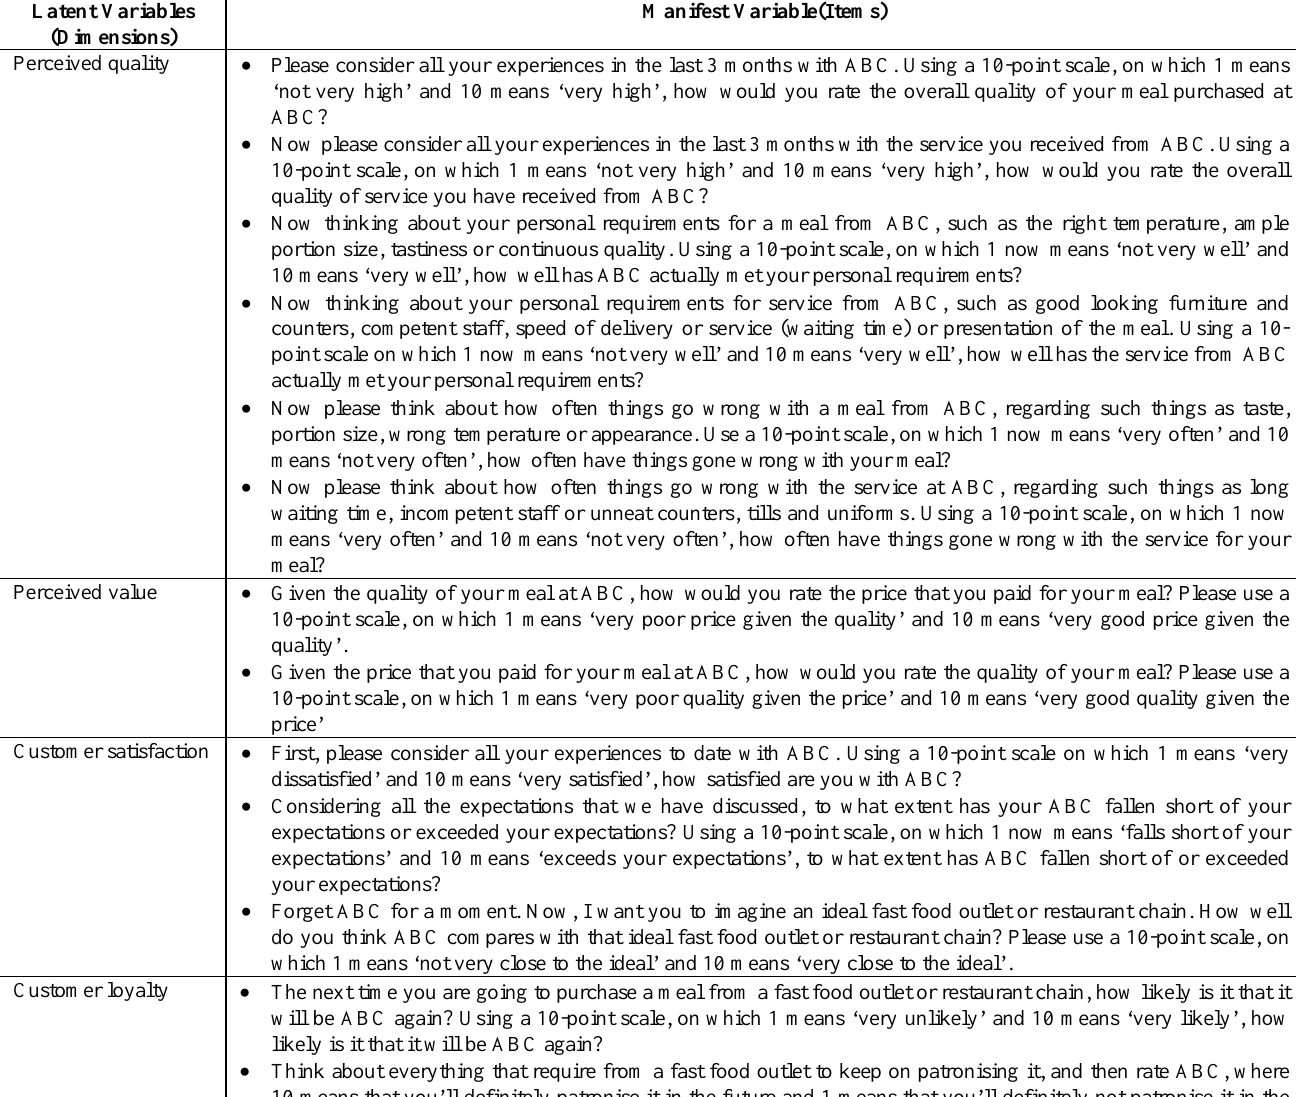
Table 1: Latent and manifest